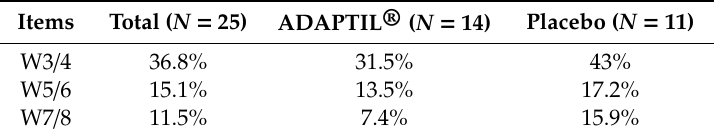
Table 3. Evolution of the proportion of time spent by bitches to nurse throughout the weaning period (percentage of total video-recorded time).